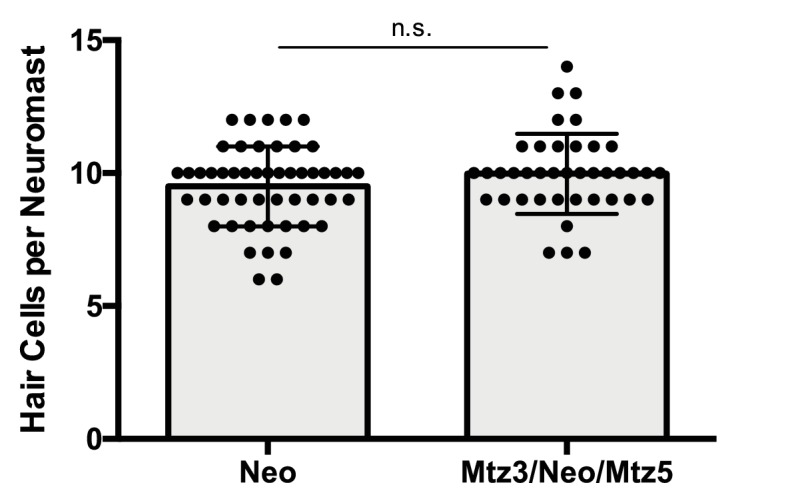
Mtz treatment does not inherently impact hair cell regeneration.Total number of hair cells per neuromast following regular hair cell regeneration (Neo) or DV cell-ablated regeneration (Mtz3/Neo/Mtz5) in non-transgenic siblings of sost:NTR-GFP fish. Neo: 9.5 ± 1.50, n = 50 neuromasts (10 fish); Mtz3/Neo/Mtz5: 9.98 ± 1.51, n = 40 neuromasts (eight fish); mean ±SD; Mann Whitney U test, p=0.2317.10.7554/eLife.43736.019Figure 6—figure supplement 1—source data 1.Mtz treatment does not inherently impact hair cell regeneration